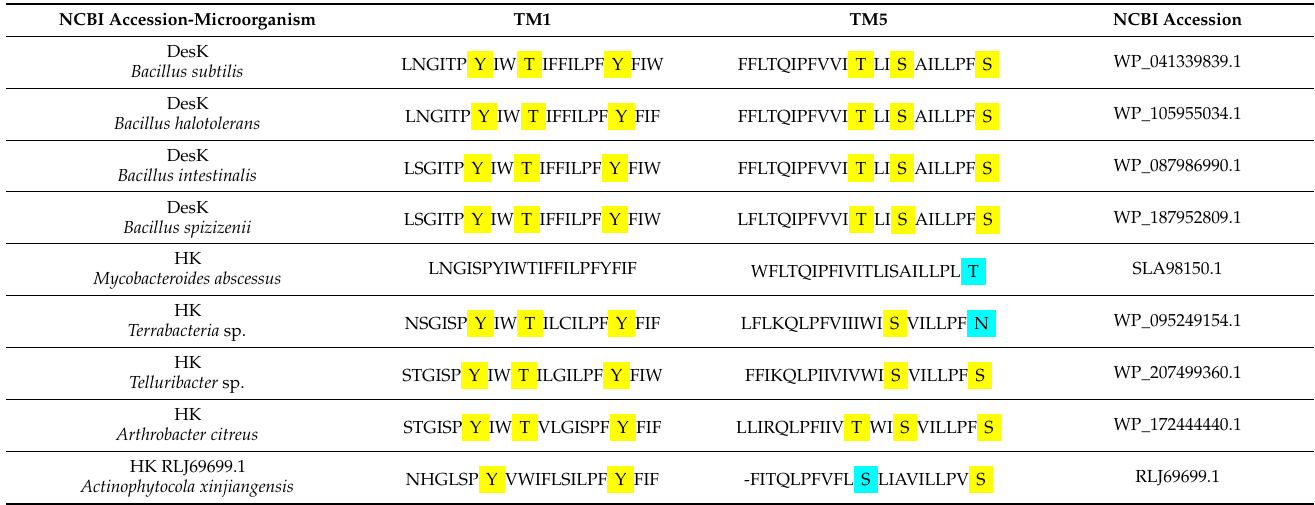
Table 1. Sequence alignment of TM1 and TM5 using DesK transmembrane domain as